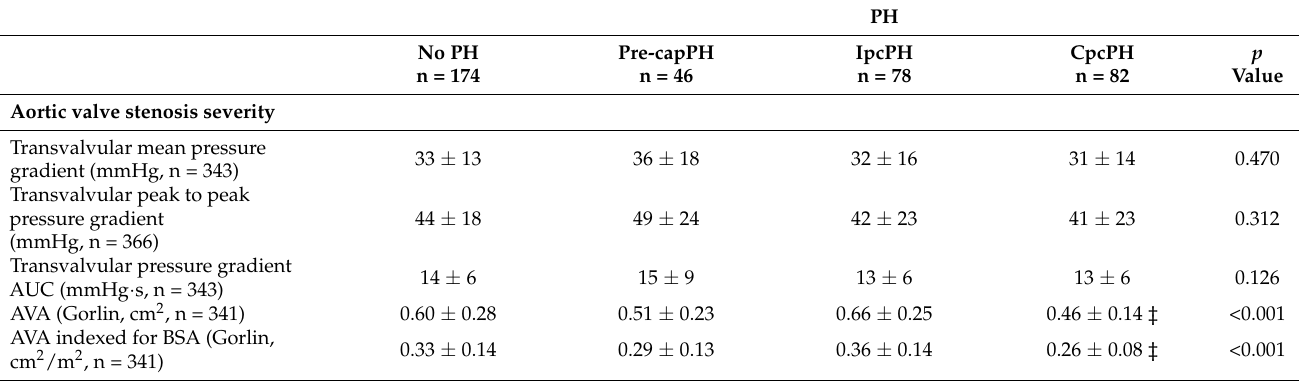
Table 4. Right and left heart catheterization parameters according to the PH